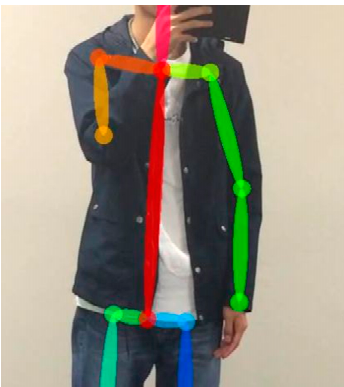
Figure 12. Example of non-detection frame.